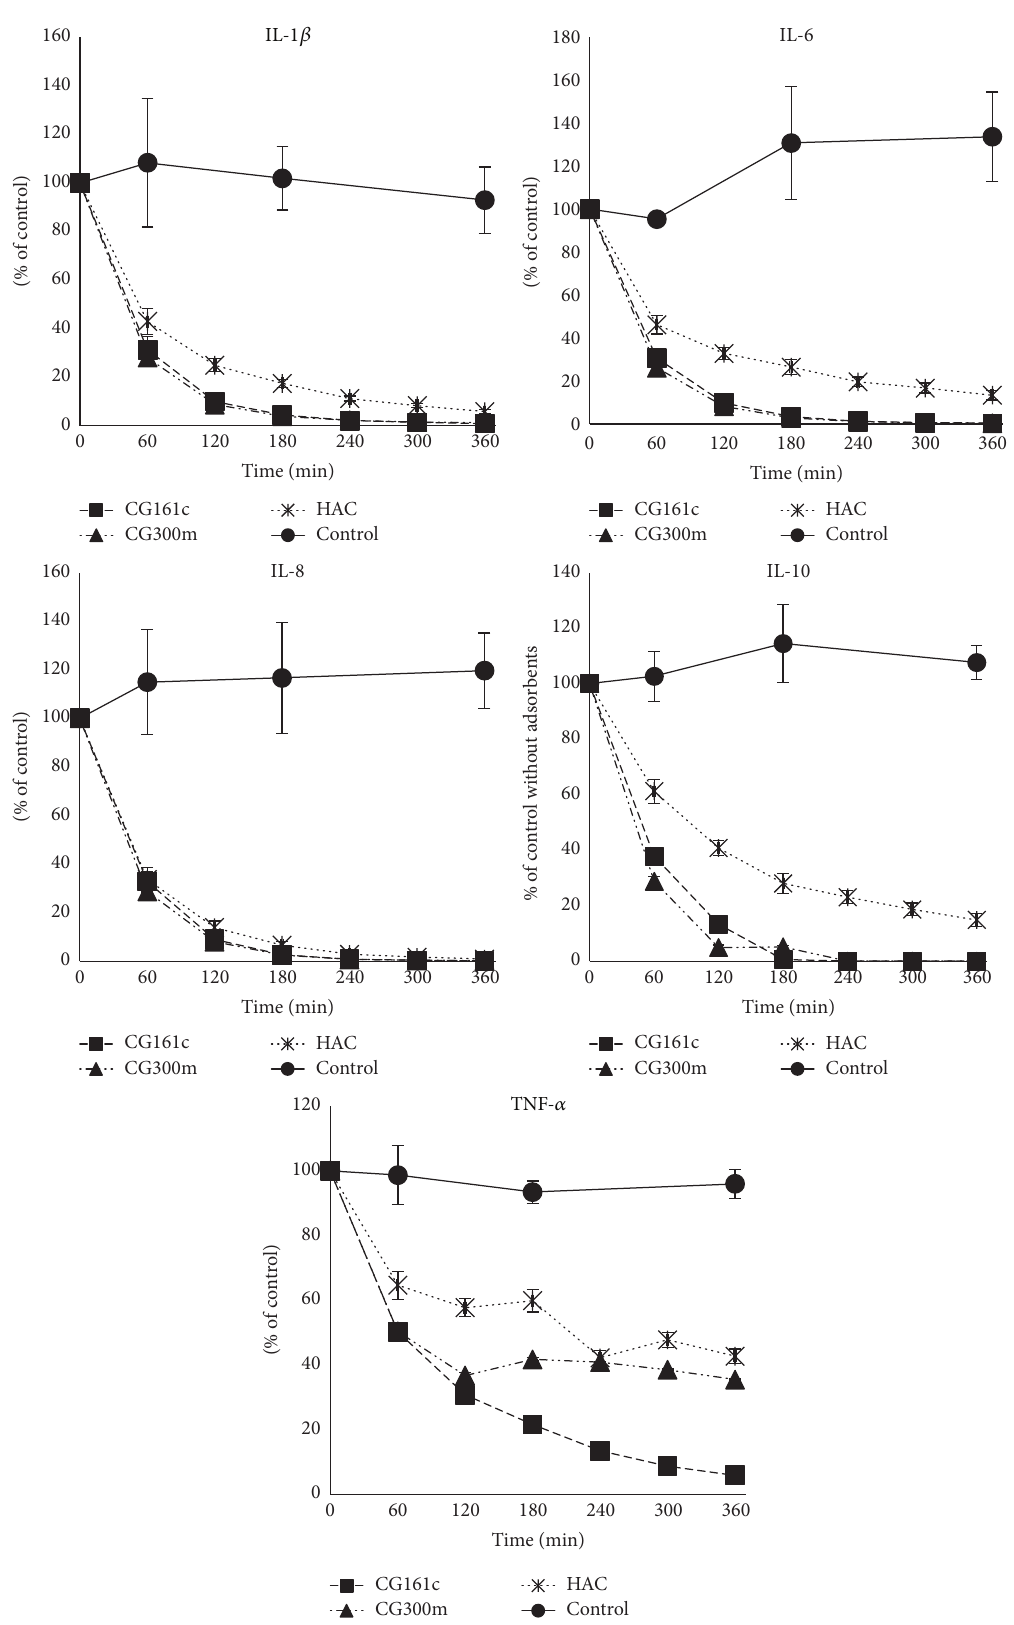
Figure 3: Cytokine removal in the dynamic model. Cytokine levels (TNF- 𝛼 , IL-1 𝛽 , IL-6, IL-8, and IL-10) in the plasma pool during 6 hours of treatment with the three tested adsorbents in the dynamic model. The results are shown in mean ±